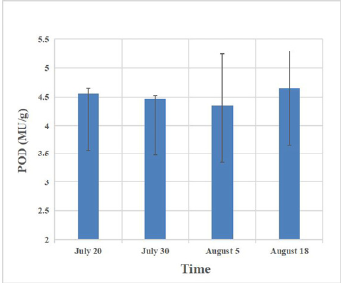
Table 2. Measuring peroxidase in host leaves at different times of injury.